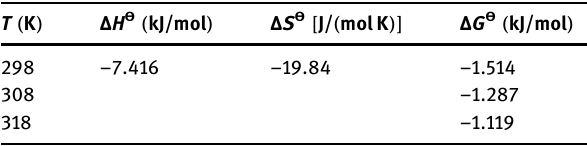
Table 3: Thermodynamic parameters of Cr ( VI ) adsorption onto